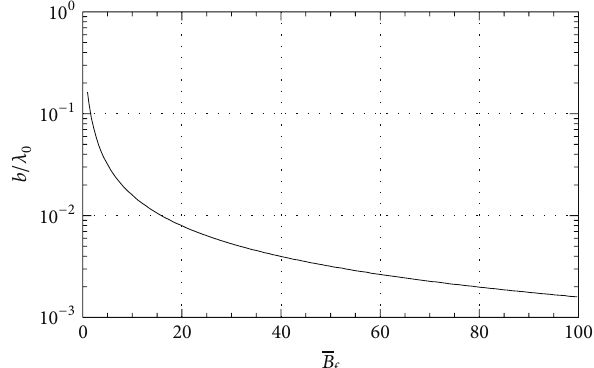
Figure 4: Optimum subwavelength thickness for directive TM radiation as a function of 𝐵 𝑓 .